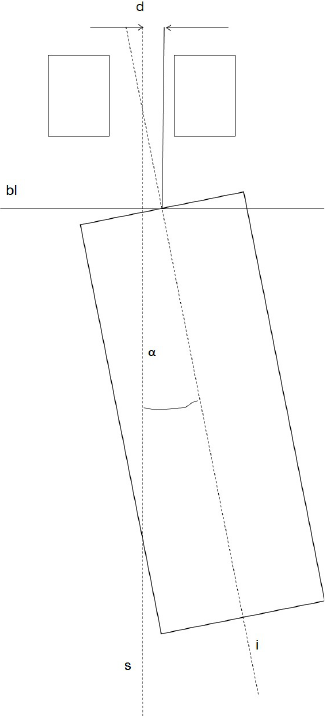
Figure 2. Two-dimensional schematic drawing of the measurements. The angle α between the median axis of the sleeve (s) and the median axis of the implant (i) was measured. Furthermore, the mismatch (d) between the planned median axis of the sleeve (s) and the median axis of the implant (i) was assessed at the bone level (bl). All measurements were likewise performed in the oro-vestibular and mesio-distal direction.